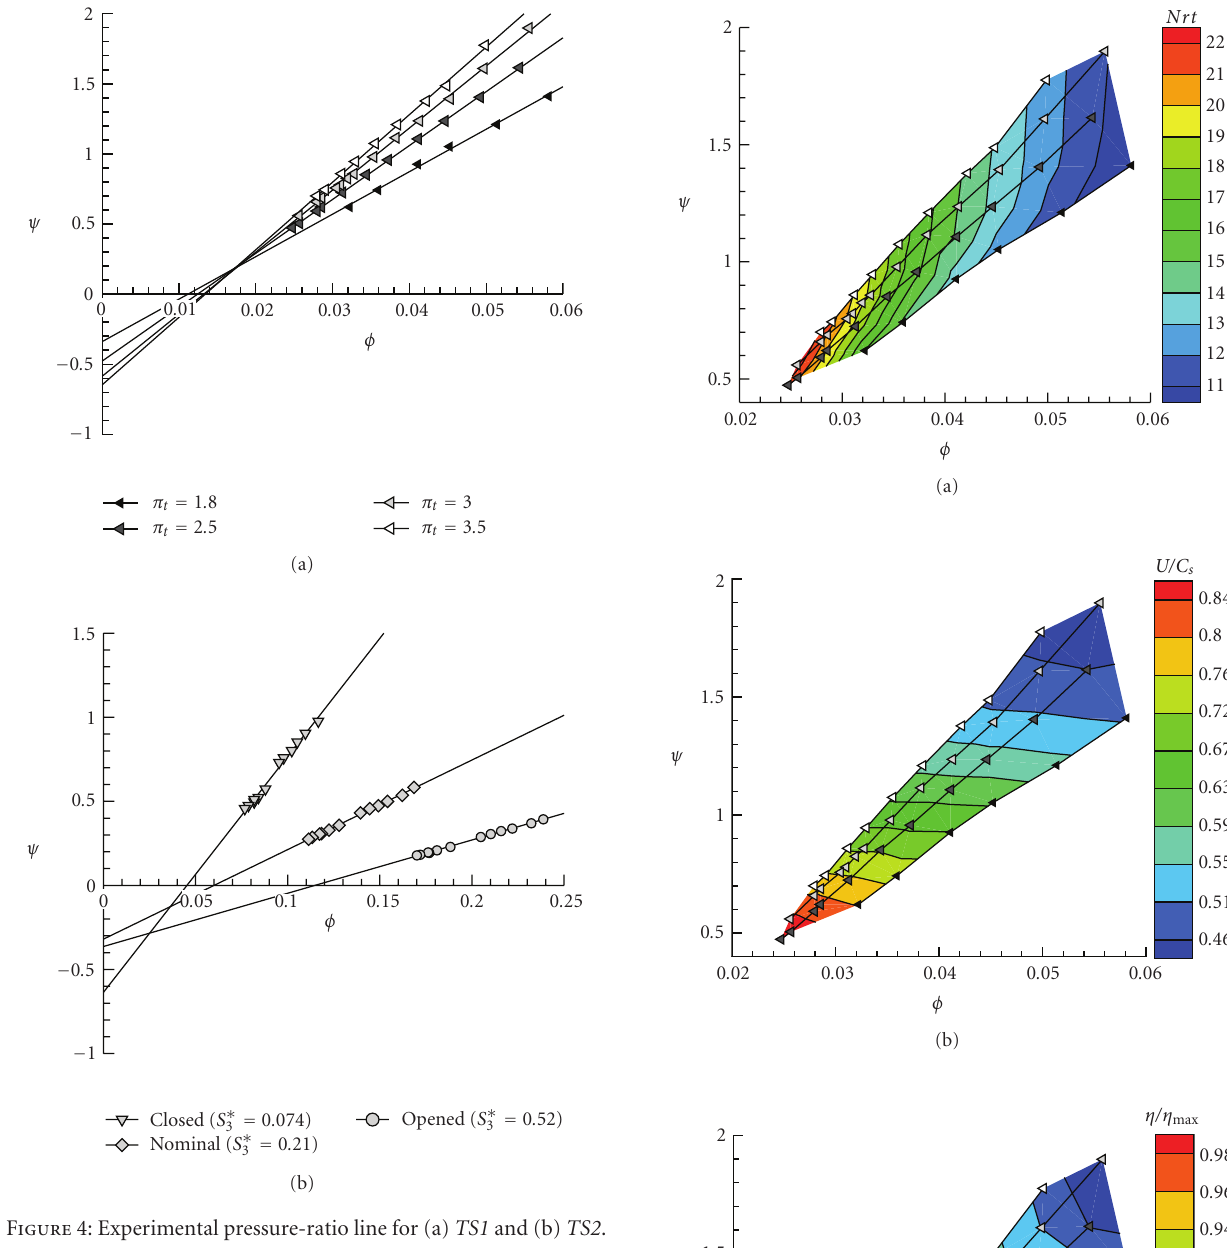
of the intercept along the axis is unexpected. According to